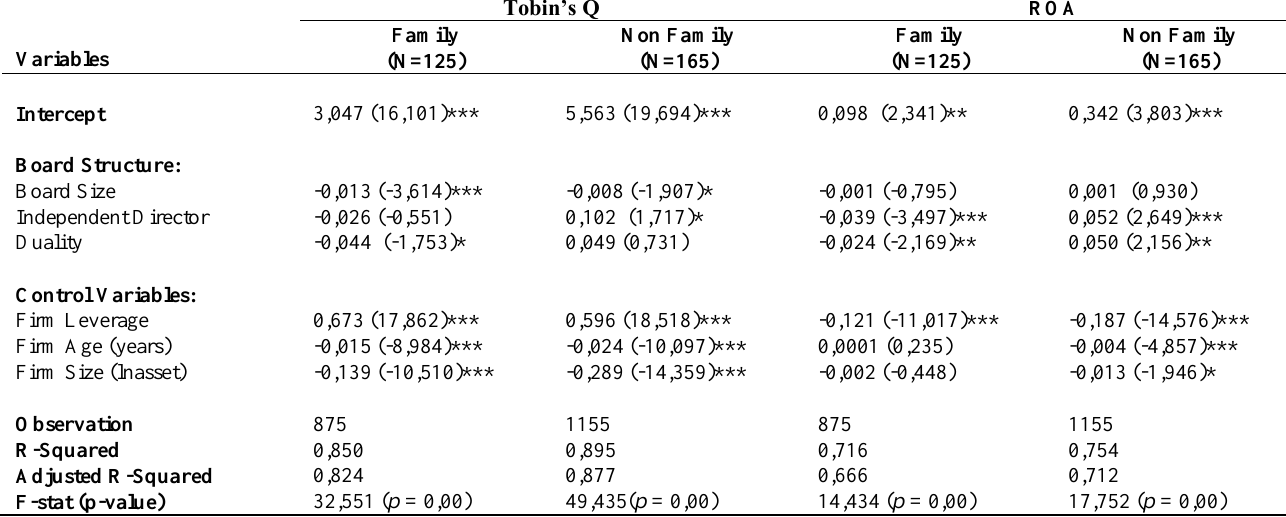
Table 3: Corporate governance and performance of family and non-family ownership in Malaysia